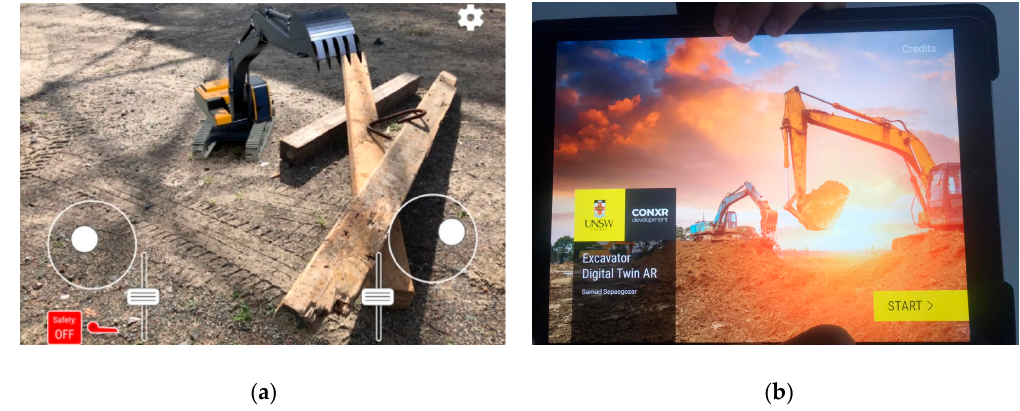
Figure 14. The collaborative model experience is presenting the entire structure and piling systems.